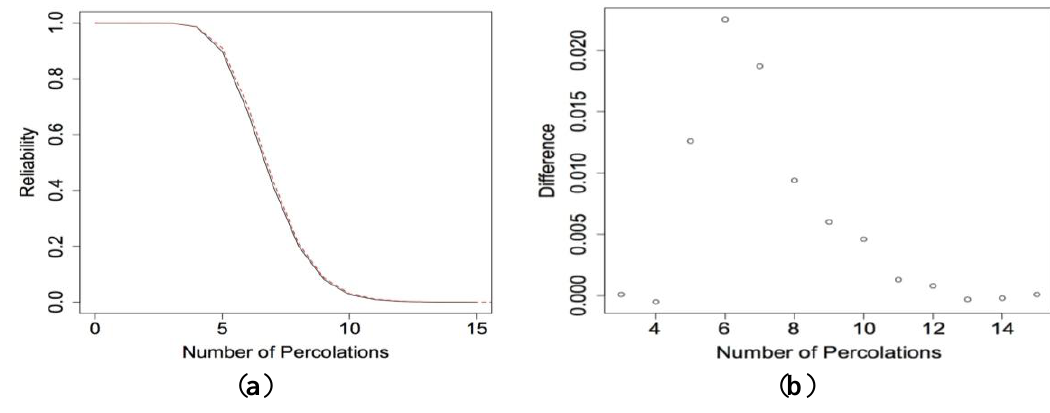
Figure 8. ( a ) R ( x ) calculated using our algorithm when the electrical current can 10 × 10 move in all directions (top curve) and when movement is restricted (bottom curve) when p = 0.90 and ( b ) the difference between the R ( x ) . 10 × 10